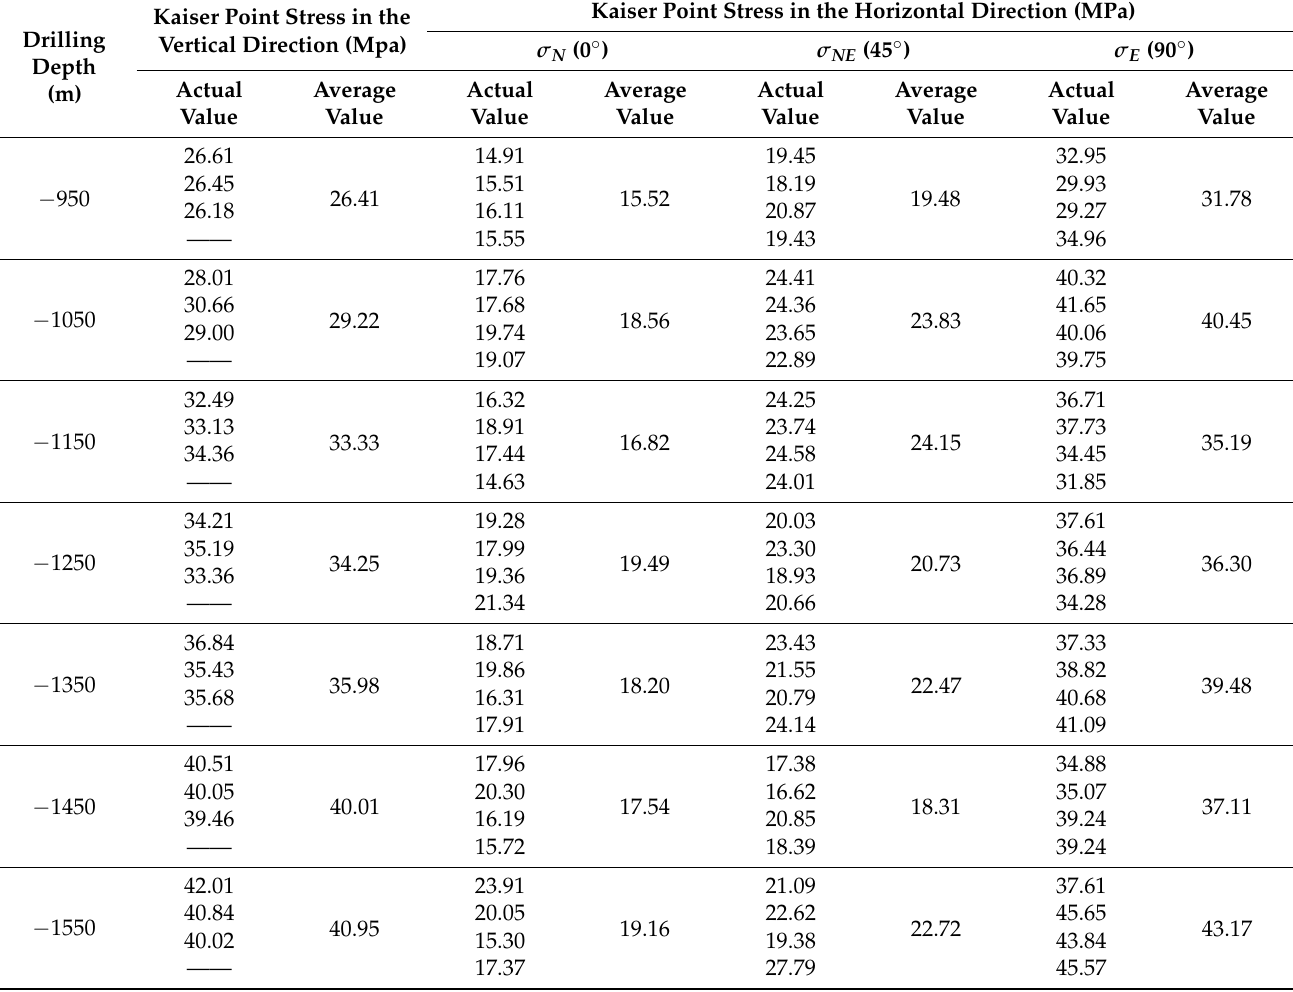
Table 1. Kaiser effect point